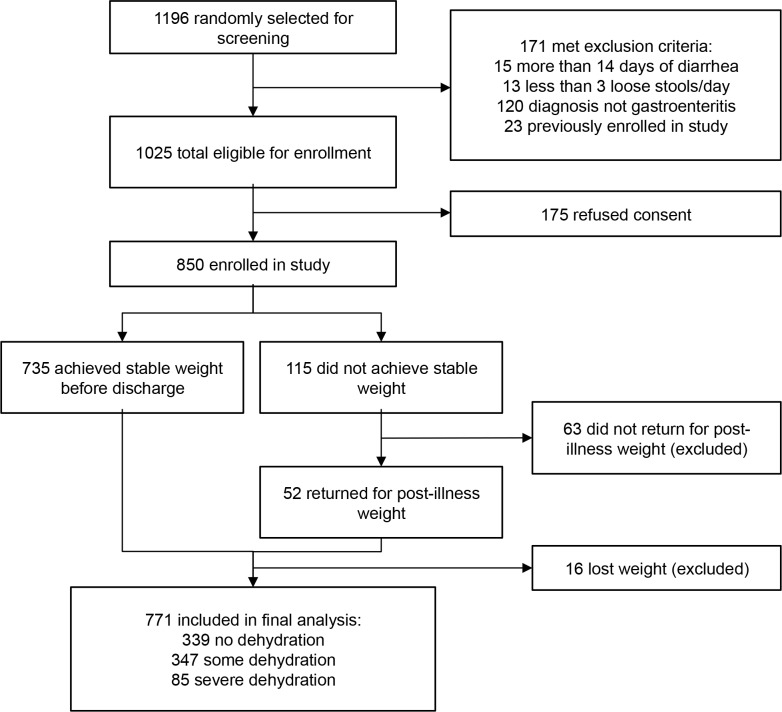
Patient enrollment.